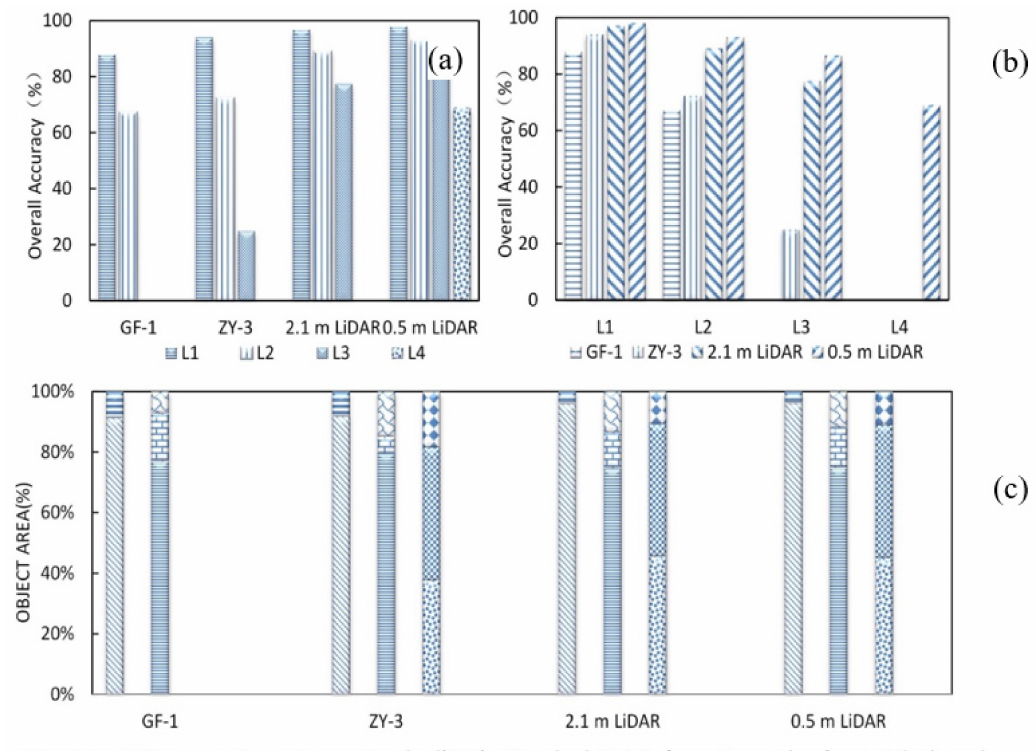
Figure 5. Total accuracy comparison results. ( a ) Average total classification accuracy of four data sources; ( b ) total classification accuracy of four levels and ( c ) proportion of area of each category of L1 to L3 layers to the area of the parent